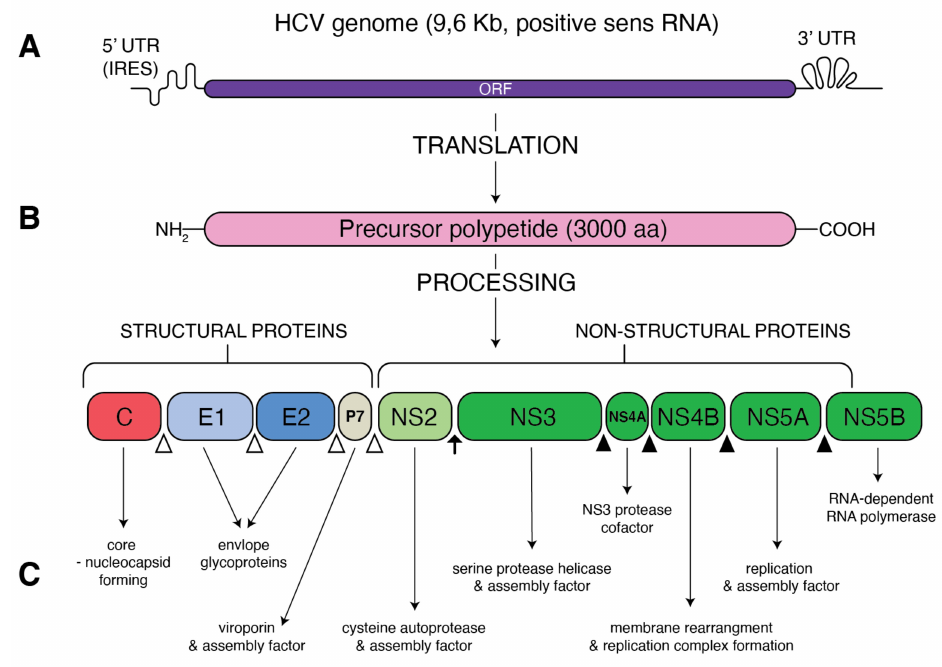
Figure 1. Schematic presentation of HCV genome and proteins. ( A ) A single open reading frame (ORF) of HCV genome is flanked by 5 (cid:48) untranslated region (5 (cid:48) UTR) that contains an internal ribosome entry site (IRES) and 3 (cid:48) UTR. ( B ) IRES- mediated translation forms a precursor protein of 3000 aa, which is then processed into 10 different proteins. Structural proteins (core, E1, E2 and p7) are cleaved from precursor thanks to the cellular signal peptidase (empty triangles) The NS2–NS3 protease auto-cleaves itself (black arrow). The NS3 protease, with NS4A as a cofactor, cleaves the remaining non-structural proteins: NS3, NS4A, NS4B, NS5A and NS5B (black triangles). ( C ) Function of the resultant structural and non-structural